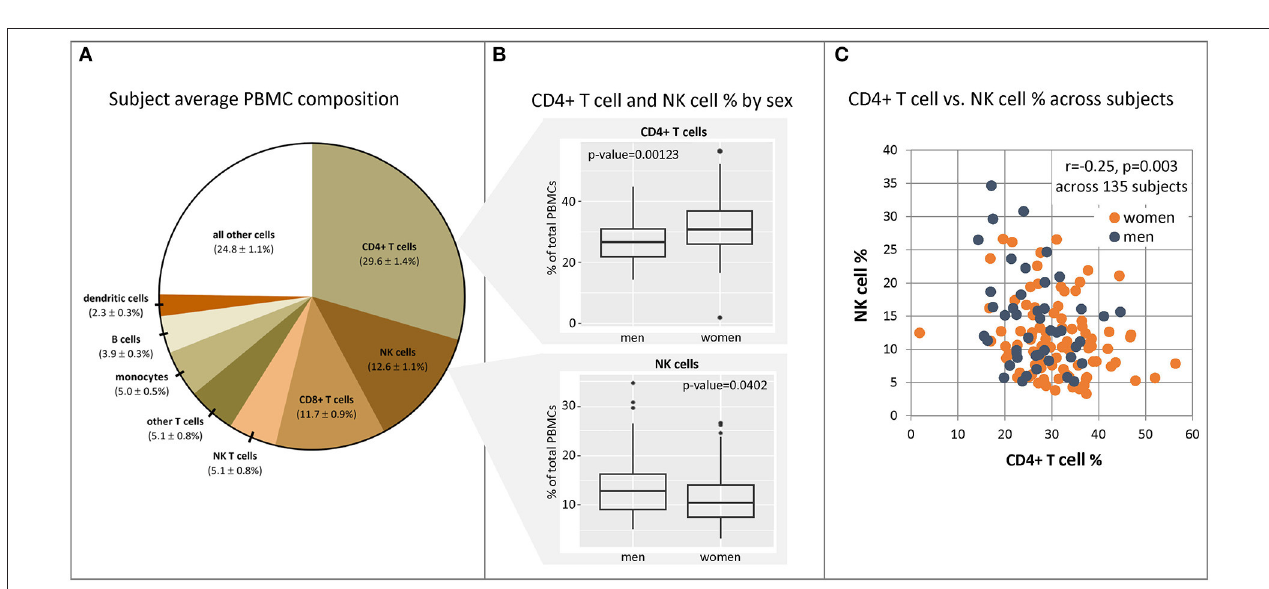
FIGURE 4 | CD4 + and NK cell fractions in PBMCs differ between males and females. PBMC samples were harvested from our cohort subjects immediately prior to vaccination, and populations of immune cell subsets were quantified in each subject sample using fluorescent antibody staining for unique cellular markers and flow cytometry. (A) mean PBMC composition and 95% confidence intervals across 135 subjects. (B) Significantly different fractions of CD4 + T cells and NK cells were found in males ( n = 45) vs. females ( n = 90). Dot plots indicating individuals’ responses are available in Supplementary Figure 3 . (C) CD4 + T cell and NK cell fractions in each subject show weak correlation with one another. Source data may be found in Supplementary Table 5 .